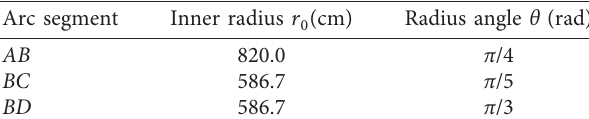
Figure 3: Circular beam on elastic foundation [21]. (a) Dimensions of the tunnel supporting structure. (b) Differential element. Table 1: Geometric parameters of primary